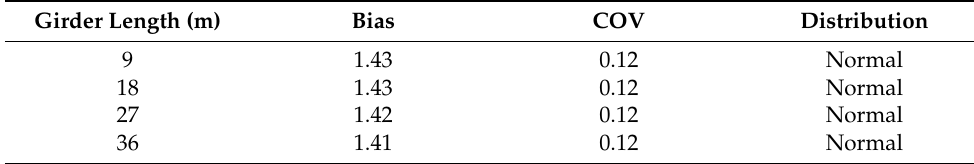
Table 6. The statistical characteristics of live load [21].